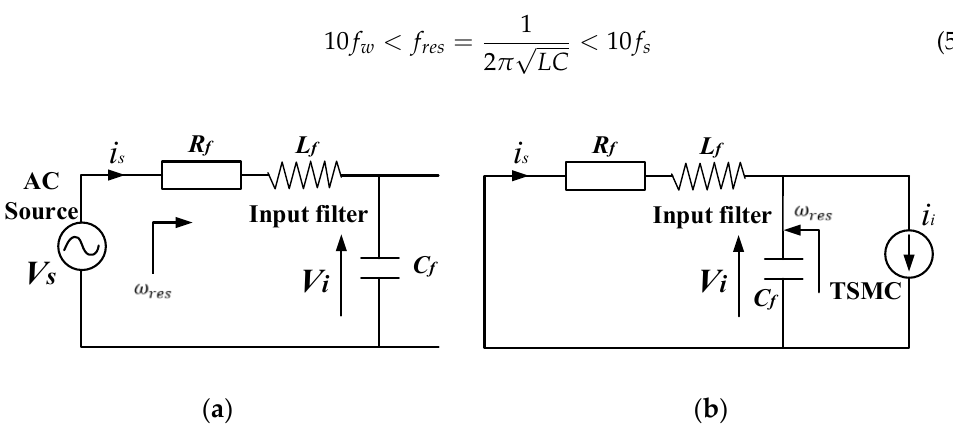
Figure 6. Possible input filter resonances. ( a ) Series resonance. ( b ) Parallel resonances. In this paper, the resonant frequency is designed and situated nearly at the seventh harmonic of the source system to excite the resonant situation, in which the TSMC system performance can be compared with the IFRS and without the